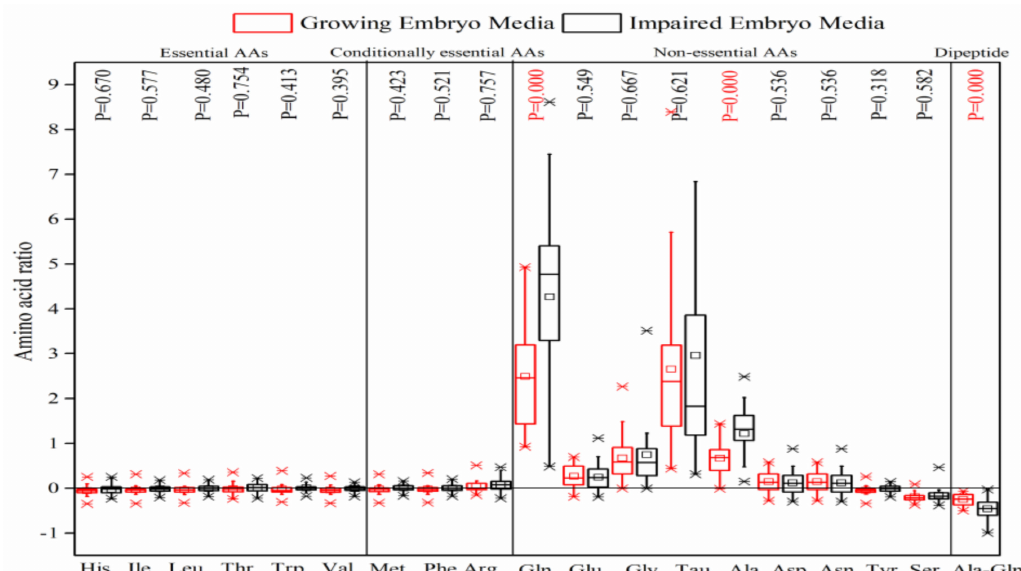
Figure 2. Comparison of the depletion / appearance of AAs by the growing and impaired human embryo media on day 5. This demonstrates the appearance of most non-essential AAs except Ser and the dipeptide of Ala-Gln in a manner that impaired the embryos, which secreted considerably higher levels of Gln and Ala, and consumed a significantly higher amount of Ala-Gln. Significant values have been marked in red above the graph ( p value < 0.05).